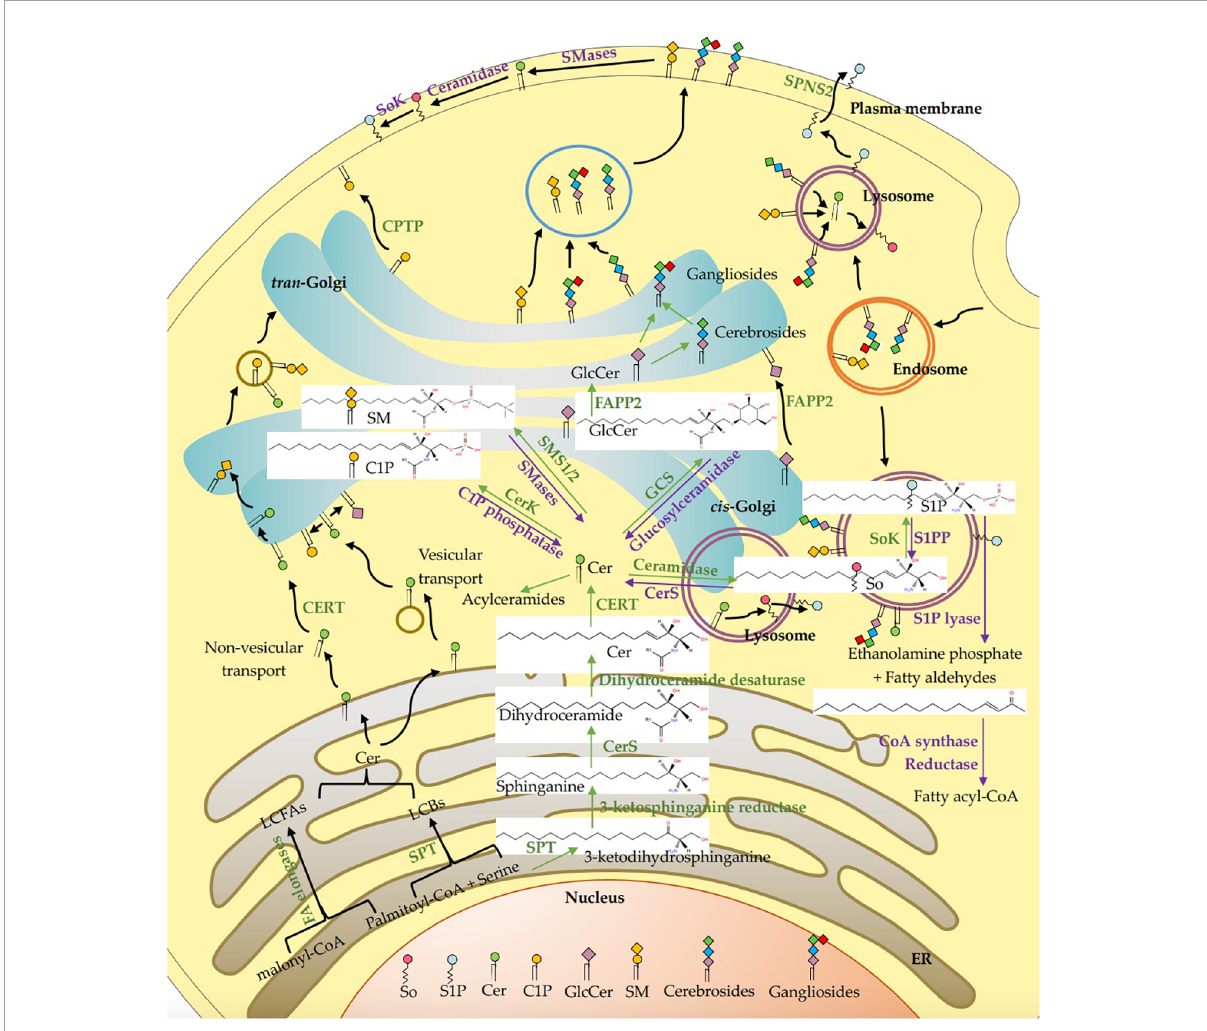
FIGURE1 Intracellular metabolism and transport of sphingolipids in mammalian cells. The de novo synthesis of sphingolipids initiates with the synthesis of ceramide (Cer) through condensation by SPT complex utilizing palmitoyl-CoA and serine, which is followed by reduction, acylation, and desaturation on the cytosolic leaflet of the ER. Fatty acids with 12–16 carbons are extended by a family of elongase enzymes to form long-chain fatty acids (LCFAs, C18-C26) in the ER, which are used in the synthesis of Cer. Cers are transported to the Golgi apparatus through vesicular transport, and non-vesicular transport via the Cer transport protein (CERT). A variety of head groups are added to Cer to form complex sphingolipids in the Golgi apparatus such as sphingomyelin (SM), ceramide-1-phosphate (CIP), and glucosylceramide (GlcCer) by sphingomyelin synthase 1/2 (SMS1/2), ceramide kinase (CerK) and glucosylceramide synthase (GCS), respectively. The GlcCer is then translocated into the lumen of the Golgi apparatus via a membrane-bound transporter and further transformed into cerebrosides and gangliosides by different enzymes. C1P is transferred from the Golgi apparatus to plasma membrane via non-vesicular translocation of C1P transfer protein (CPTP). The SM, cerebrosides and gangliosides are delivered to the plasma membrane via vesicular trafficking, and then SM is metabolized to Cer, sphingosine (So) and sphingosine-1-phosphate (S1P). Cer is deacylated by ceramidase to generate So, and then phosphorylated by sphingosine kinase (SoK) to produce S1P in the lysosome and also in plasma membrane. The S1P lyase cleaves S1P into ethanolamine phosphate and fatty aldehydes, the latter are further metabolized and reduced to fatty acyl-CoA. All synthetic reactions to produce complex sphingolipids from Cer are reversible, such as SM, C1P, and GlcCer are hydrolyzed by sphingomyelinase (SMase), C1P phosphatase and glucosylceramidase, respectively. S1P is dephosphorylate by S1P phosphatase (S1PP) to get So, which is acylated by ceramide synthases (CerS) to form Cers. In the lysosome, SM, cerebrosides and gangliosides are metabolized by each hydrolase to produce Cer, and then degraded by acid ceramidase to generate sphingosine. In addition, Cers can also be acylated at the 1-OH position to form acylceramides. ER, Endoplasmic reticulum; SPT, serine palmitoyltransferase; CerS, ceramide synthase; CERT, ceramide transfer protein; Cer, ceramide; LCFAs, long chain fatty acids; LCBs, long chain bases; CerK, ceramide kinase; C1P, ceramide-1-phosphate; SMS1/2, sphingomyelin synthase; SMases, Sphingomyelinase; CerS, ceramide synthase; So, sphingosine; SoK, sphingosine kinase; S1P, sphingosine-1-phosphate; S1PP, sphingosine-1-phosphate phosphatase; GlcCer, glucosylceramide; GCS, glucosylceramide synthase; FAPP2, phosphatidylinositol-4-phosphate adaptor protein